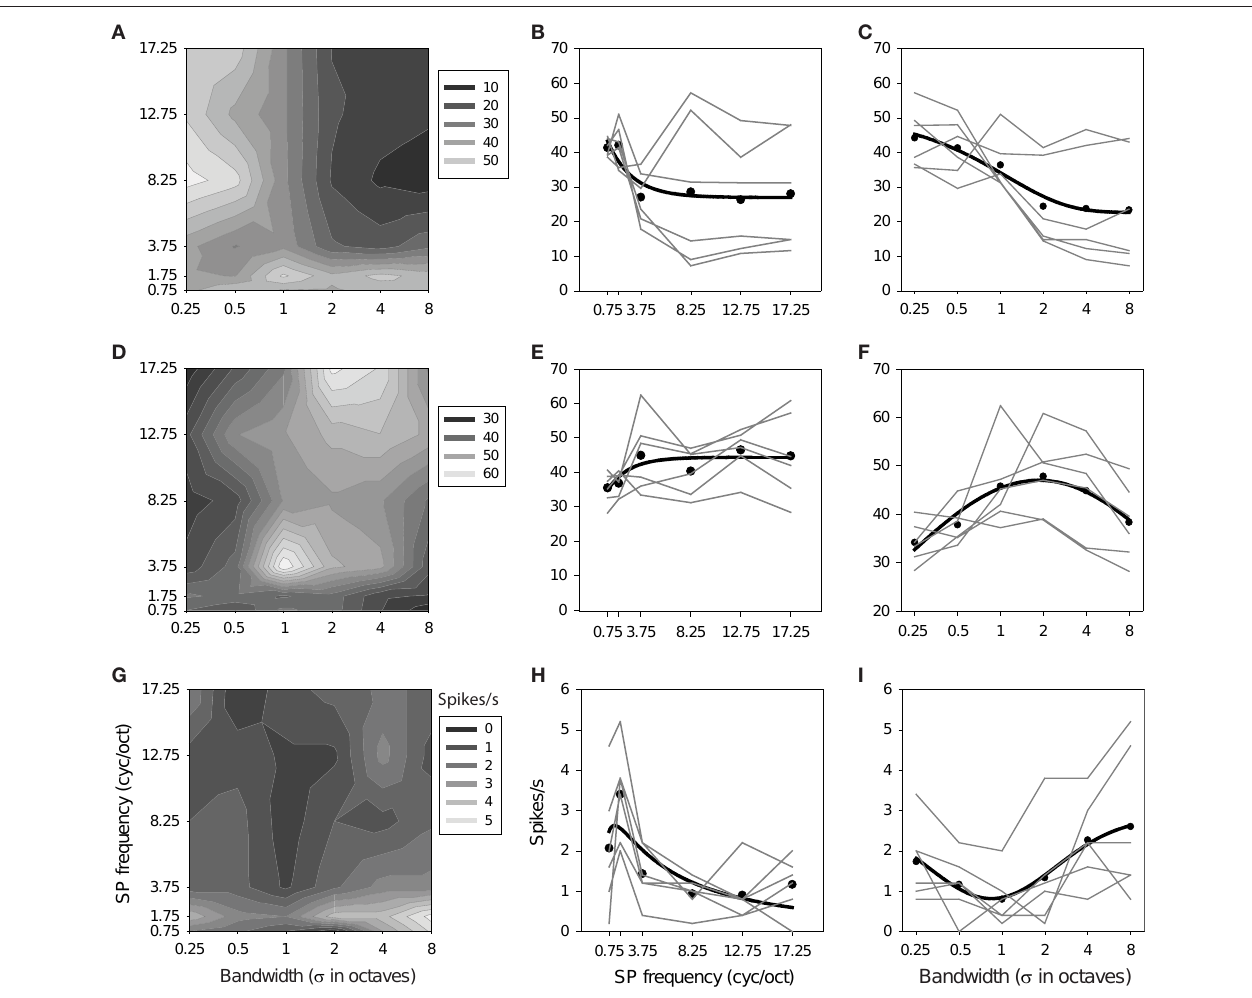
FiGure 8 | interaction effects between ripple frequency and bandwidth. Each row depicts results from one neuron. Contour plots (A,d,G) and factorial plots (B,C,e,F,h,i) display responses as a function of both variables. Other details as in Figures 4 and 6